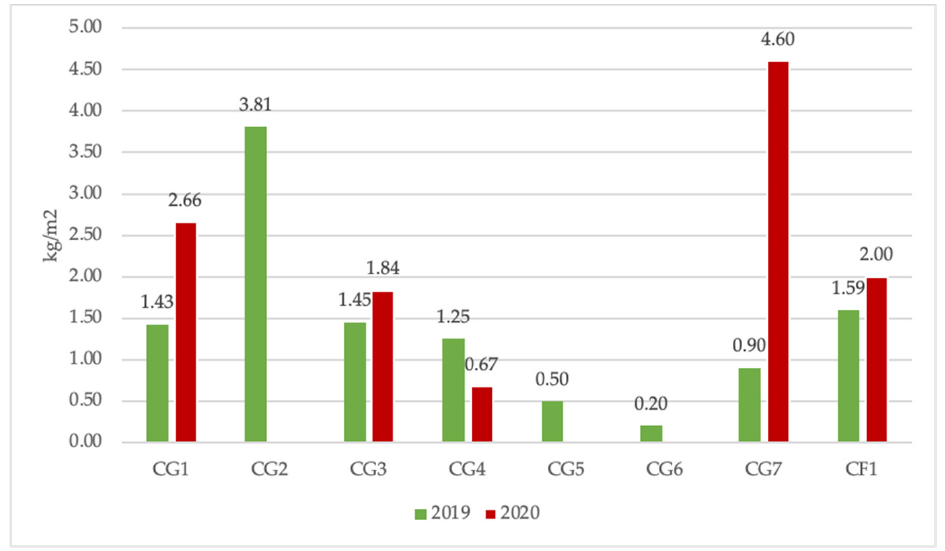
Figure 3. 2019 and 2020 crop productivity of 7 community gardens and 1 city farm measured in kg/m 2 of cultivated surface area (in 2020 CG7 increased the cultivated surface area from 76 to 100 m 2 ). Total yield in the 2019 growing season from the spaces in the study was 16,979